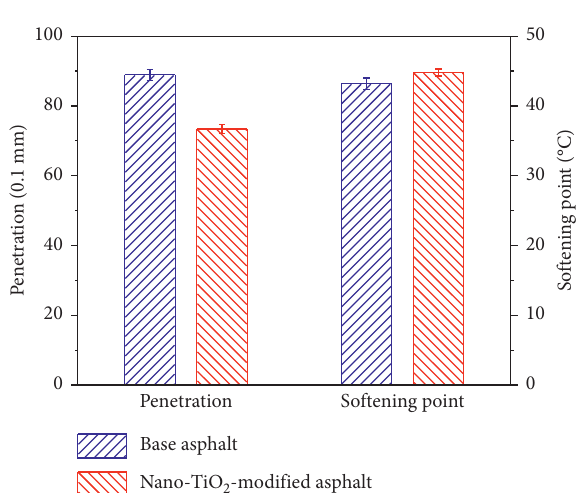
Figure 4: Penetration and softening point results of asphalt samples with and without nano-TiO 2